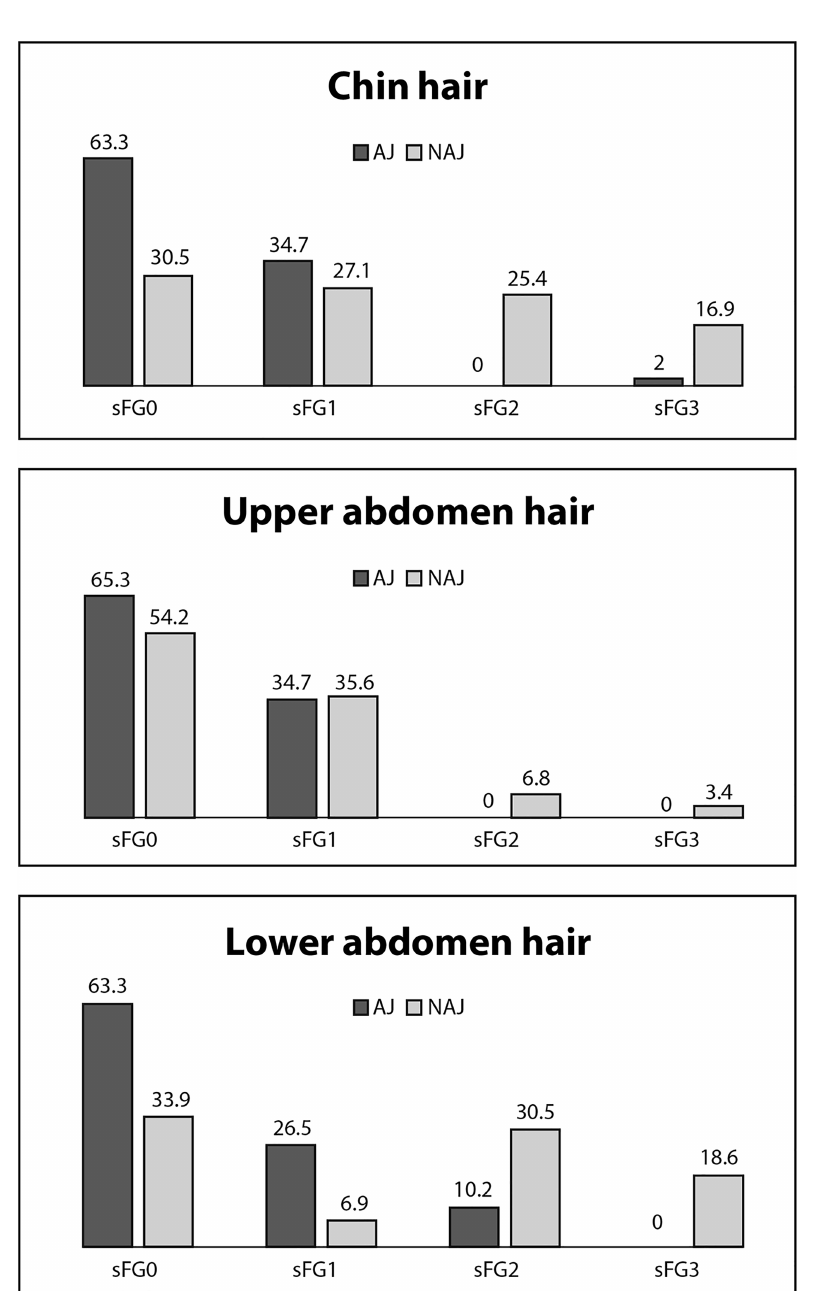
Fig 1. Simplified Ferriman–Gallwey (sFG) score of different body areas among Ashkenazi and non-Ashkenazi